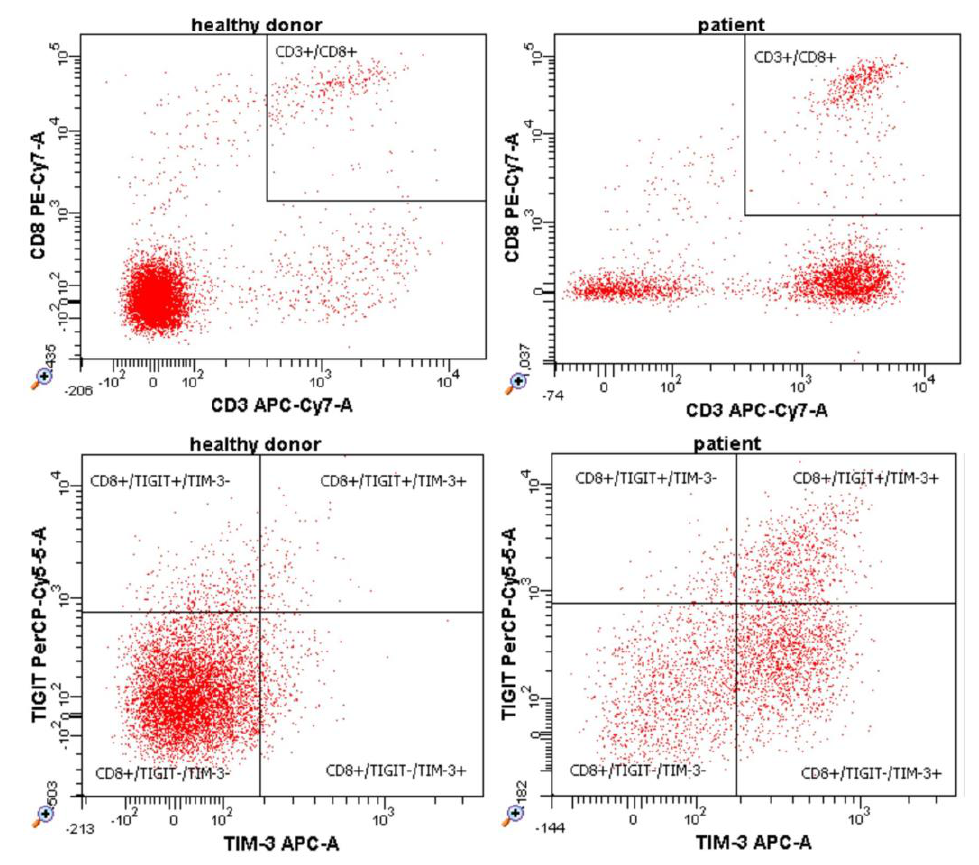
Figure 6. Representative example of flow cytometry dot plots presenting certain subpopulations of cytotoxic T cells in the entire population of cytotoxic T cells in healthy donors and melanoma pa- tients.